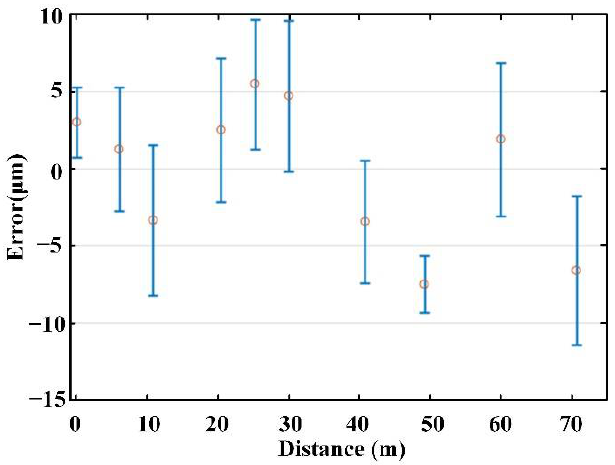
Figure 9. Error diagram of measurement results, where the standard deviations are labeled with error bars (blue lines) and the midpoints of the error bars give the average values of 20 measurements errors at each position (red circles).